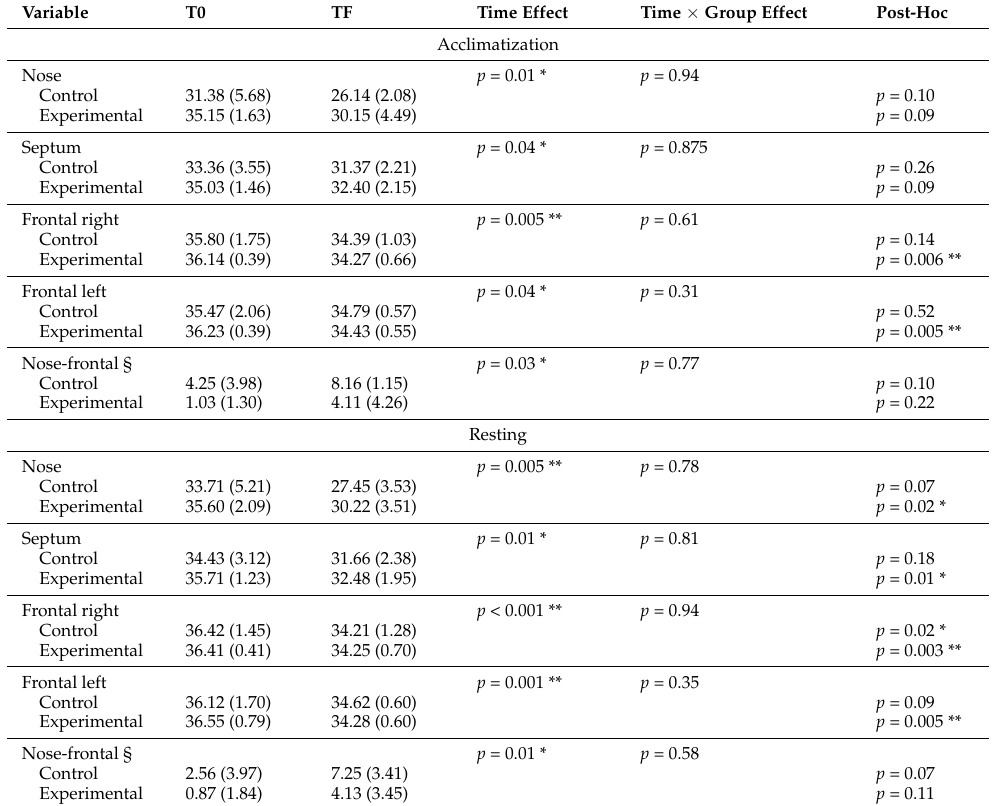
Table 5. Thermal variables from T0 to TF in control and experimental groups. Variables are expressed as Mean (SD). * p < 0.05, ** p < 0.01.